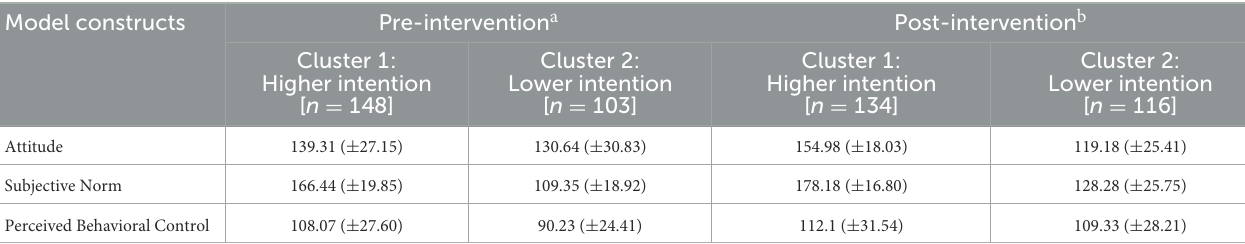
TABLE 2 Description of clusters in Pre-intervention and post-intervention phases as per the defining constructs. Model